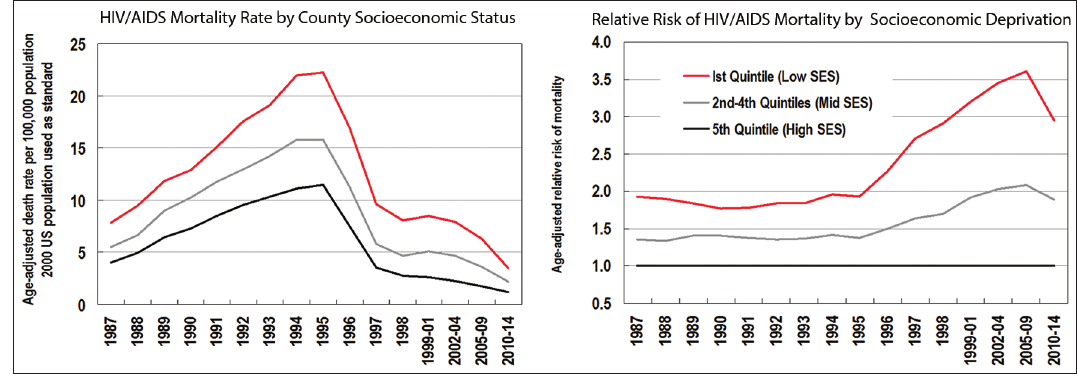
Fig ure 24. Trends in HIV/AIDS Mortality by County Socioeconomic Status, Both Sexes Combined, United States, 1987-2014 Source: Singh GK, Azuine RE, Siahpush M. Widening Socioeconomic, Racial, and Geo graphic Disparities in HIV/AIDS Mortality in the United States, 1987-2011. Advances in Preventive Medicine. 2013. DOI: 10.1155/2013/657961. Updat- ed data derived from the US National Vital Statistics System.